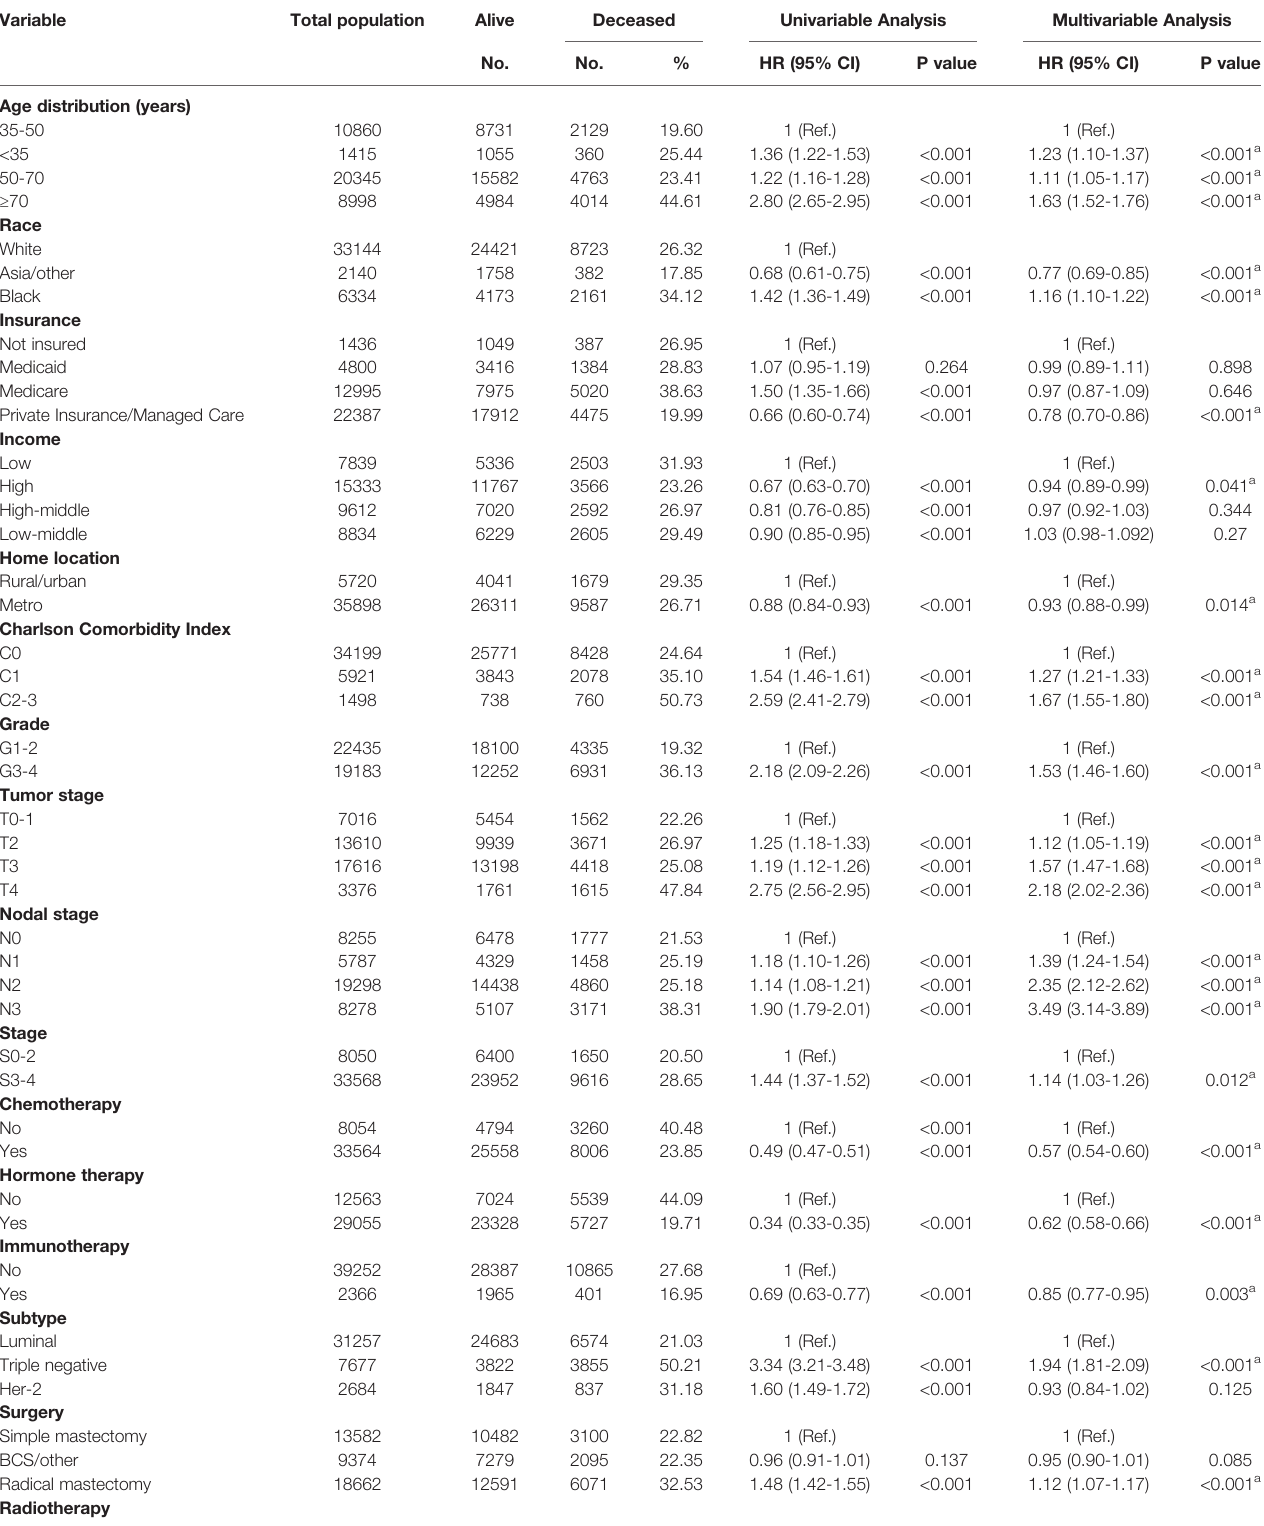
TABLE 2 | Univariable and multivariable Cox analysis of overall survival for patients with locally advanced breast